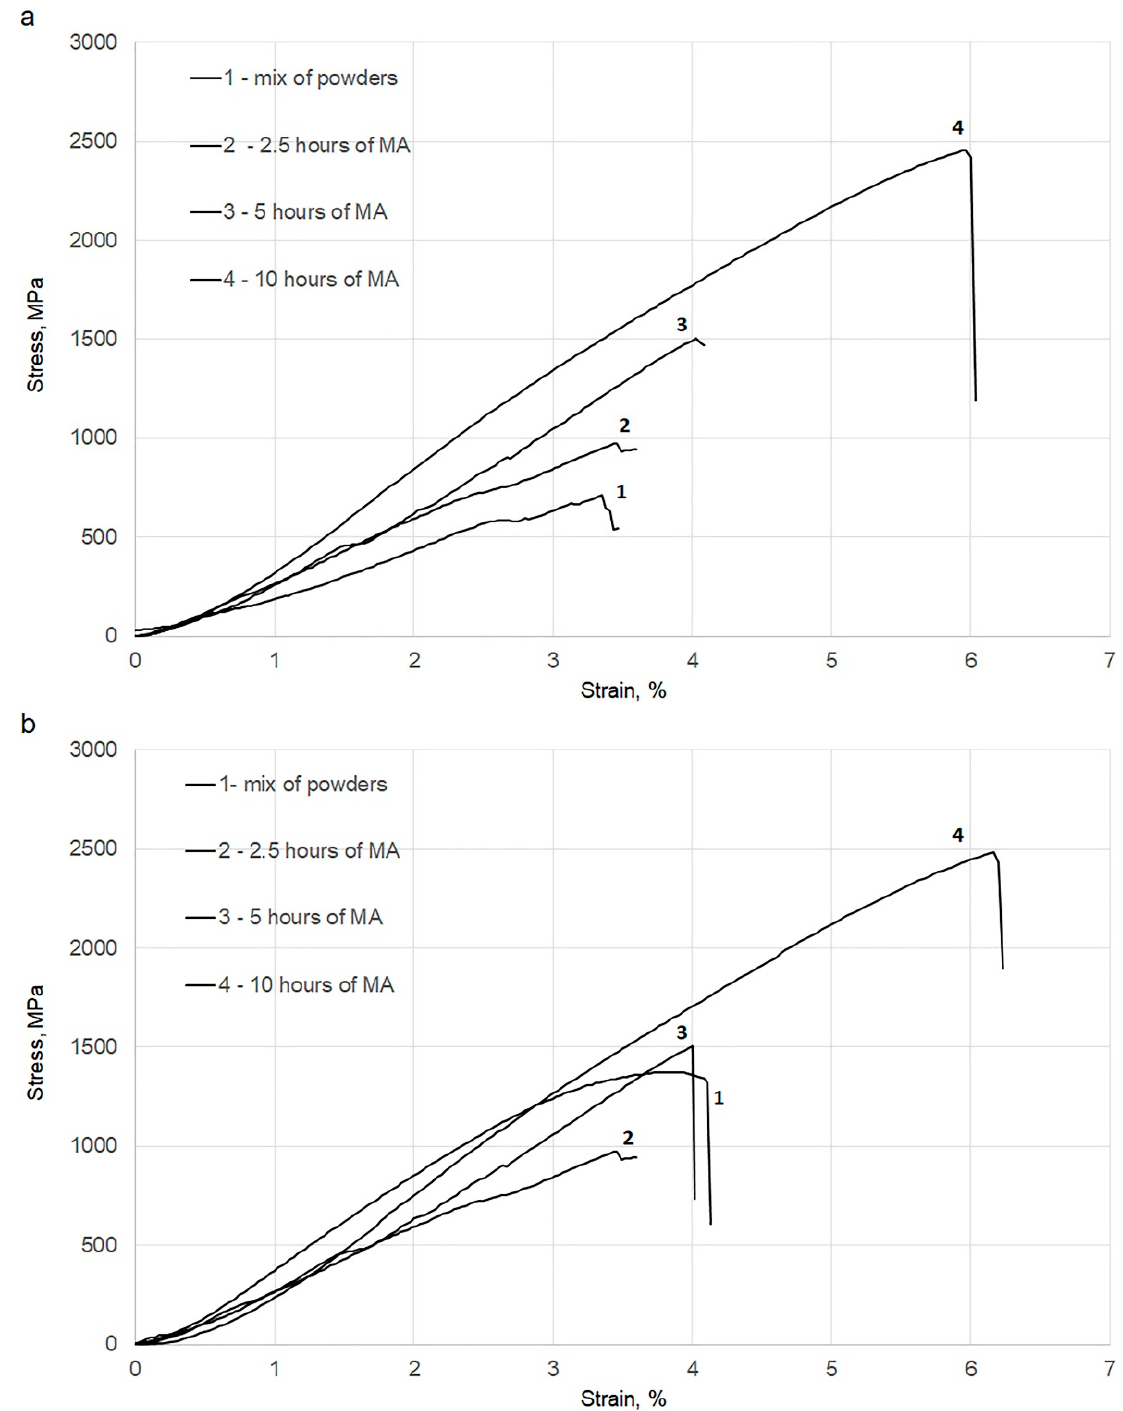
Figure 10. Compressive stress–strain curves of bulks produced by the pressure-assisted sintering process: ( a )—35Fe30Cr20Ni10Mo5W; ( b )—30Fe30Cr20Ni10Mo10W.